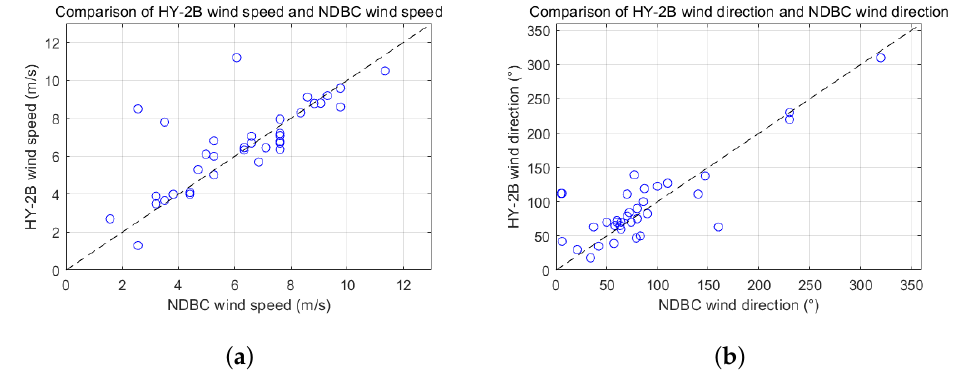
Figure 10. Comparison of NDBC buoy wind field and HY-2B SCA wind field. ( a ) Wind speed comparison results; ( b ) wind direction comparison